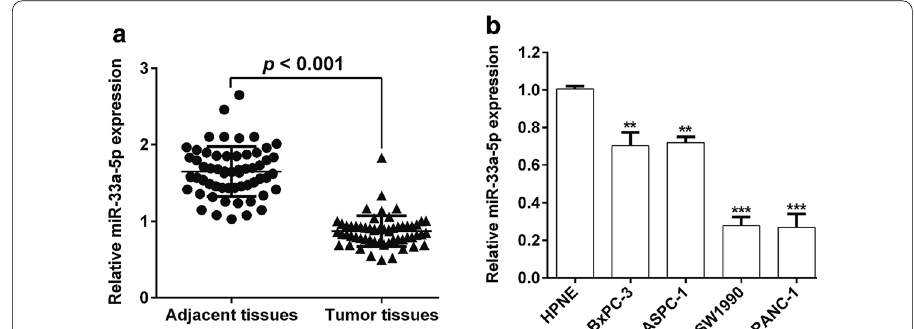
Fig. 1 Downregulated miR-33a-5p in PDAC. A We performed RT-qPCR analysis to determine miR-33a-5p expression level in paired PDAC tissue samples and adjacent pancreatic tissues (n RT-qPCR analysis to measure miR-33a-5p expression level in BxPC-3, ASPC-1, SW1990, PANC-1 and HPNE cell lines. ** p < 0.01, *** p < 0.001 vs.